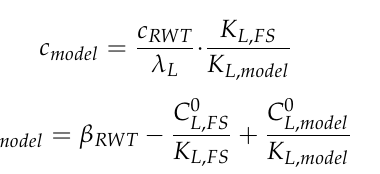
Figure 5. Experimental lift coefficient ( a ), drag coefficient ( b ) and lift-to-drag ratio ( c ) of the blade profiles used in the outdoor prototype (BGF) and wind tunnel model (WT) rotor for a chord Reynolds of 150,000.